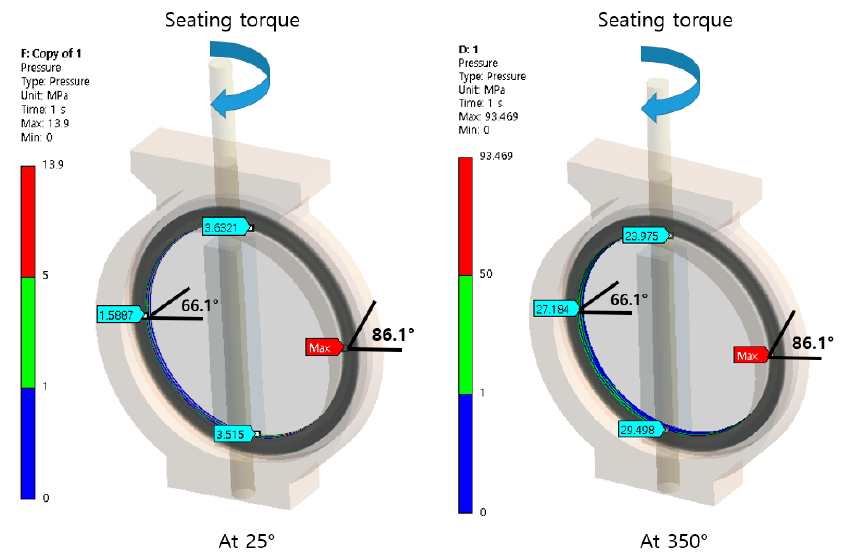
Figure 18. The contact pressure distribution of the seven-layer model. To compare the contact pressures of the QOBV and the TOBV, a thermal–structural coupled analysis of TOBV with the same boundary and load conditions at 350 ◦ C was performed. The contact pressures distribution of TOBV at each position are 18.96 MPa (A), 22.622 MPa(B), 46.122 MPa(C), 29.906 MPa(D), 28.429 MPa(E), 13.19 MPa(F), 148.9 MPa(G), and 13.548 MPa(H), respectively. The results of the QOBV contact pressures distribu- tion at each position are 22.169 MPa(A), 23.241 MPa(B), 25.343 MPa(C), 16.278